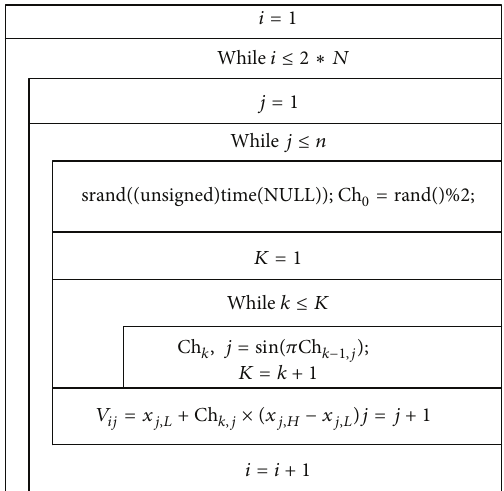
Figure 1: The 𝑁 - 𝑆 chart of chaotic phase.